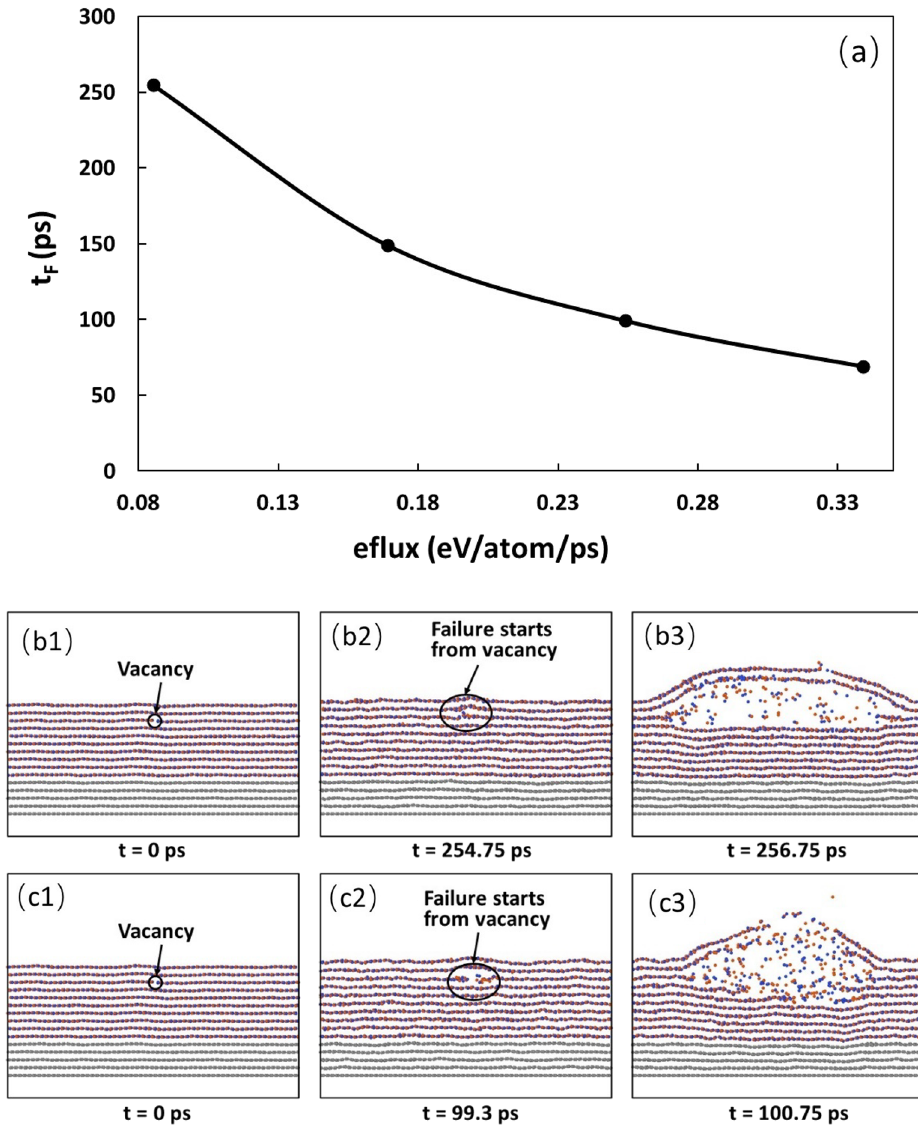
Figure 4. ( a ) Variation of failure start time with the heating rate. In the simulations, the sample with 10 h-BN layers is used with B vacancy in the middle of the 3rd layer. ( b1 – b3 ) Failure of the sample with the heating rate of 0.085 eV/atom/ps. ( c1 – c3 ) Failure of the sample with the heating rate of 0.254